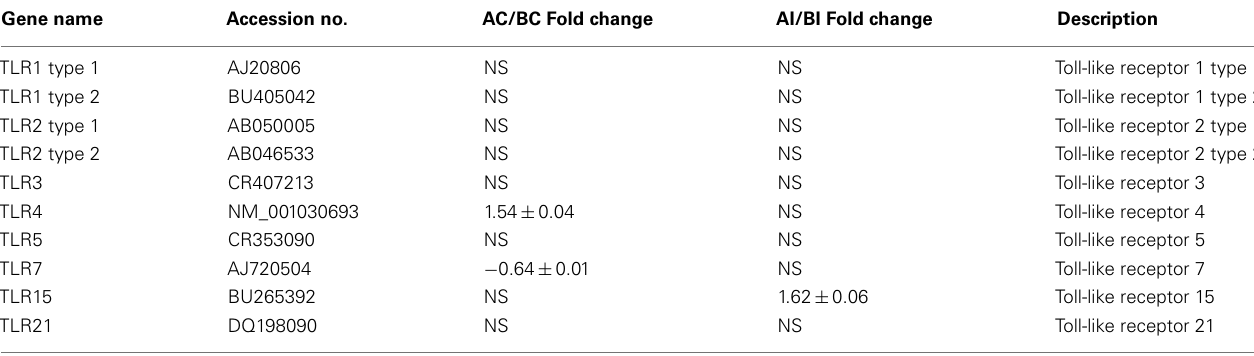
Table 2 | Fold change ofToll-like receptor genes between heterophils isolated from lineA and B chickens using microarray